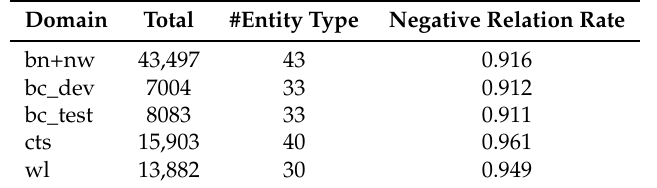
Table 1. ACE2005 dataset statistics.